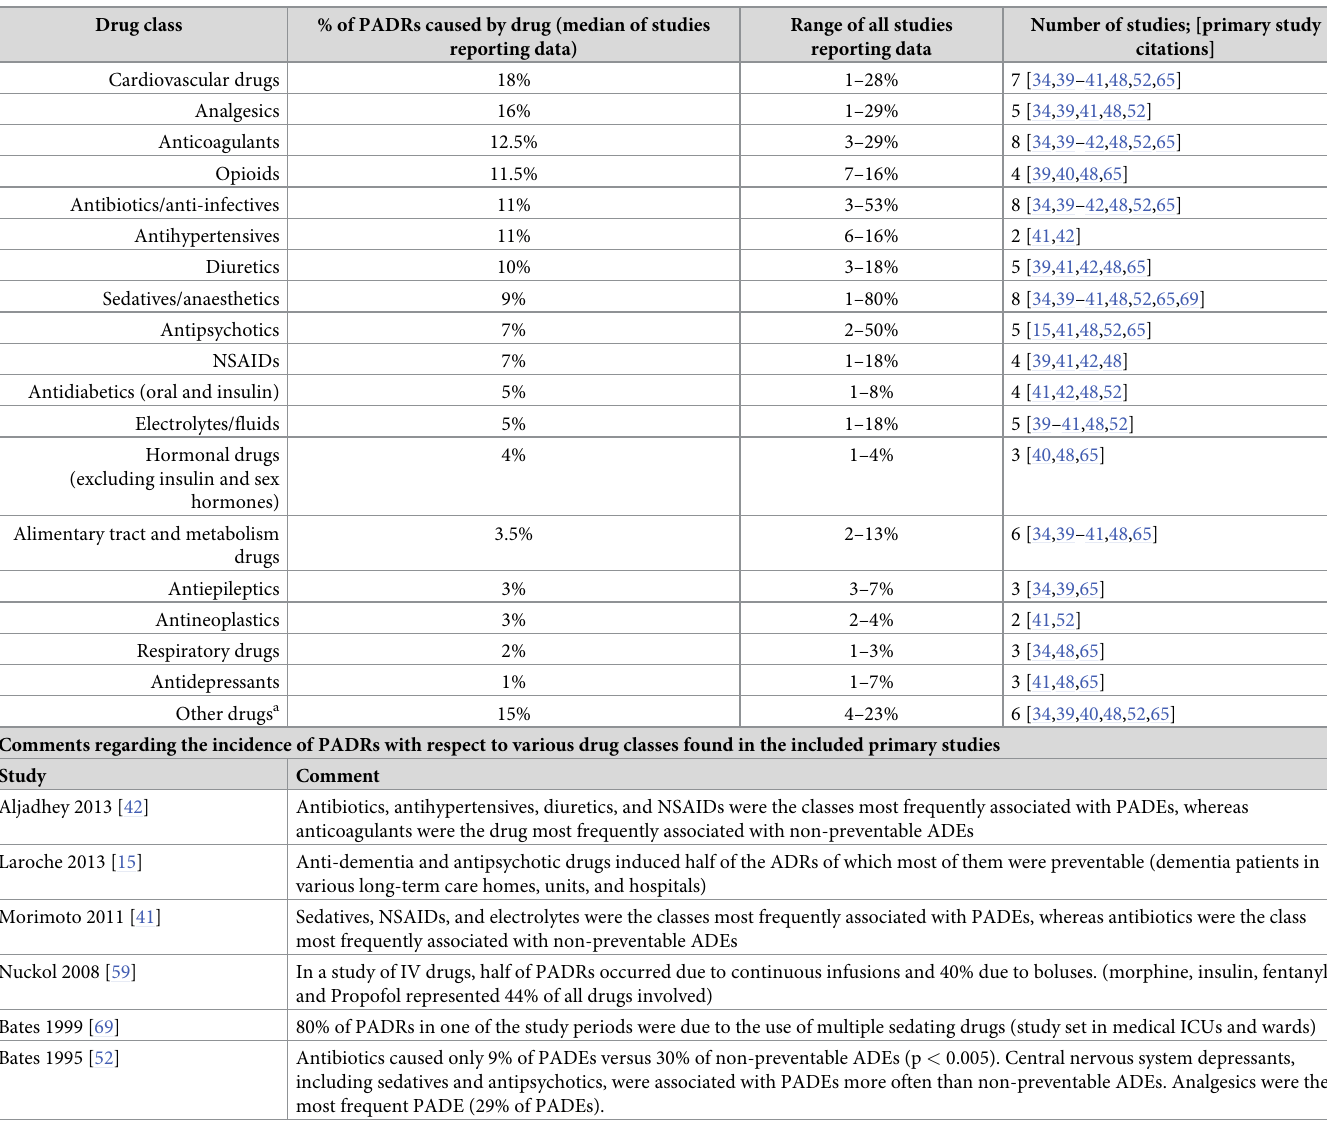
Table 7. The influence of drug class on PADR